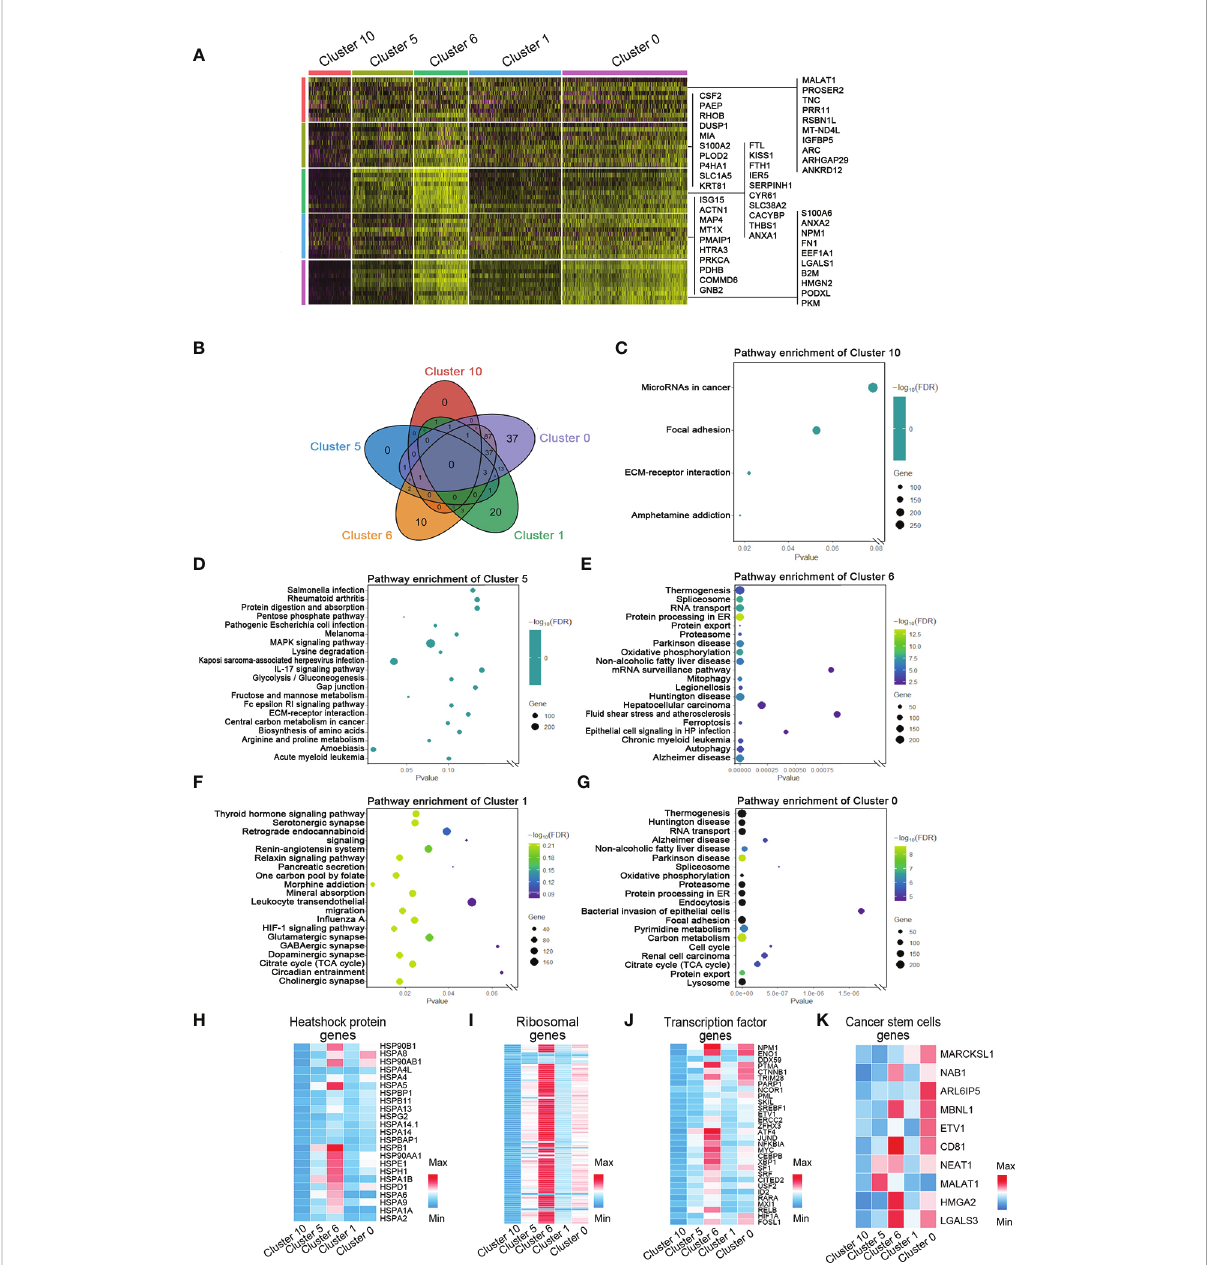
FIGURE 4 Marker genes and the relative signaling pathways of fi ve hypoxia-dependent spatial clusters. (A) Heatmap of expression of maker genes in hypoxia-dependent spatial clusters. (B) The Venn diagram of the gene ontology (GO) pathway in cluster 0, cluster 1, cluster 6, cluster 5, and cluster 10. (C) Dot plot of the top 4 GO terms of differentially expressed genes in cluster 10. (D) Dot plot of the top 20 GO terms of differentially expressed genes in cluster 5. (E) Dot plot of the top 20 GO terms of differentially expressed genes in cluster 6. (F) Dot plot of the top 20 GO terms of differentially expressed genes in cluster 1. (G) Dot plot of the top 20 GO terms of differentially expressed genes in cluster 0. (H – K) Expression-level scaled heatmap of heat shock proteins, genes, ribosomal genes, transcriptional factor genes, and cancer stem cell genes of cluster 0, cluster 1, cluster 6, cluster 5, and cluster